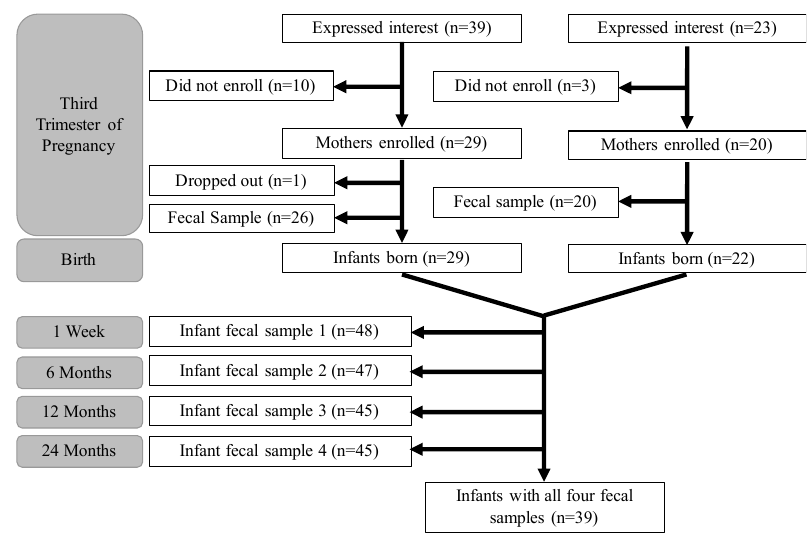
Figure 2. Participant flowchart of mothers and infants in ARCHBG.